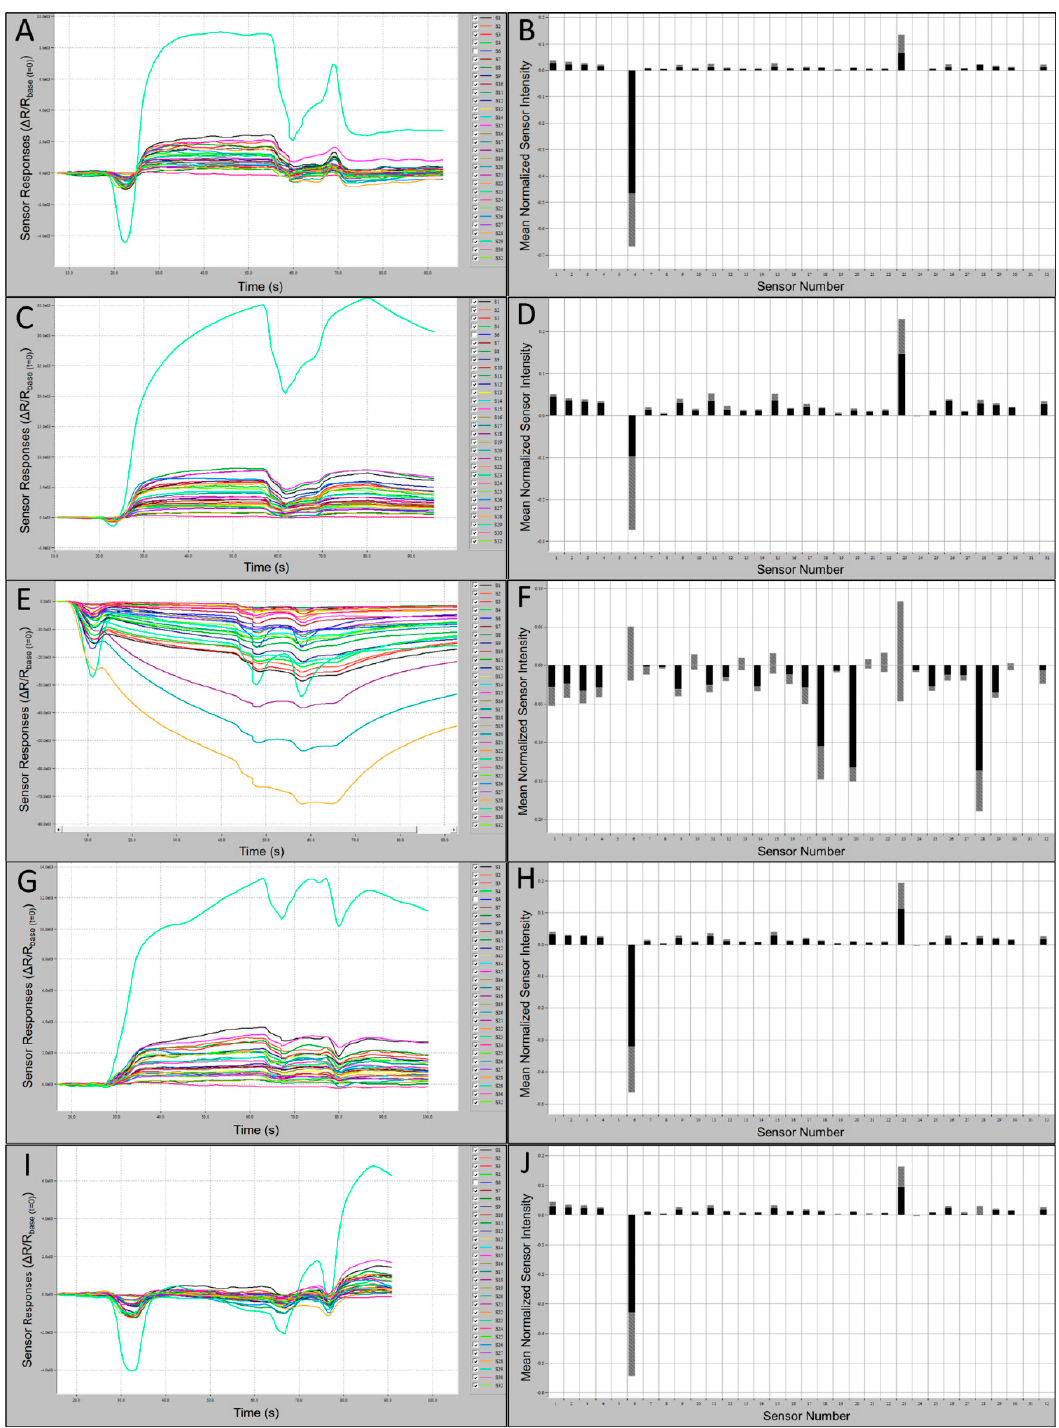
Figure 3. Bat air sample 60 s e-nose analysis runs with 32-sensor outputs and associated smellprint signatures. ( A ) Sensor-array outputs for Eptesicus fuscus (EPFU); ( B ) Smellprint signature of Eptesicus fuscus ; ( C ) Sensor outputs for Myotis austroripiarus (MYAU); ( D ) Smellprint signature of Myotis austroripiarus ; ( E ) Sensor outputs for Myotis leibii (MYLE); ( F ) Smellprint signature of Myotis leibii ; ( G ) Sensor outputs for Perimyotis subflavus (PESU); ( H ) Smellprint signature of Perimyotis subflavus ; ( I ) Sensor outputs for ambient-air control (CTRL) samples from field bat collection sites; ( J ) Smellprint signature of CTRL air samples. Sensor S6 is not displayed due to overly intense responses that obscure all other sensors. Smellprint bar graphs indicate mean sensor responses in black ( ± SEM, gray error